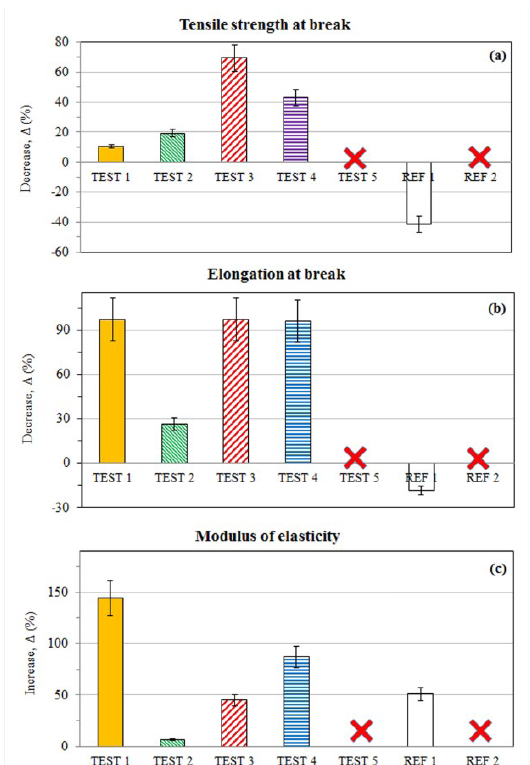
Figure 8. The relative change of the mechanical properties after the biodegradation test compared to the initial samples: (a) tensile strength at break, (b) relative elongation at break, (c) modulus of elasticity. Table 6 demonstrates the results of a linear mixed effects simulation of the obtained data on stress-strain properties.